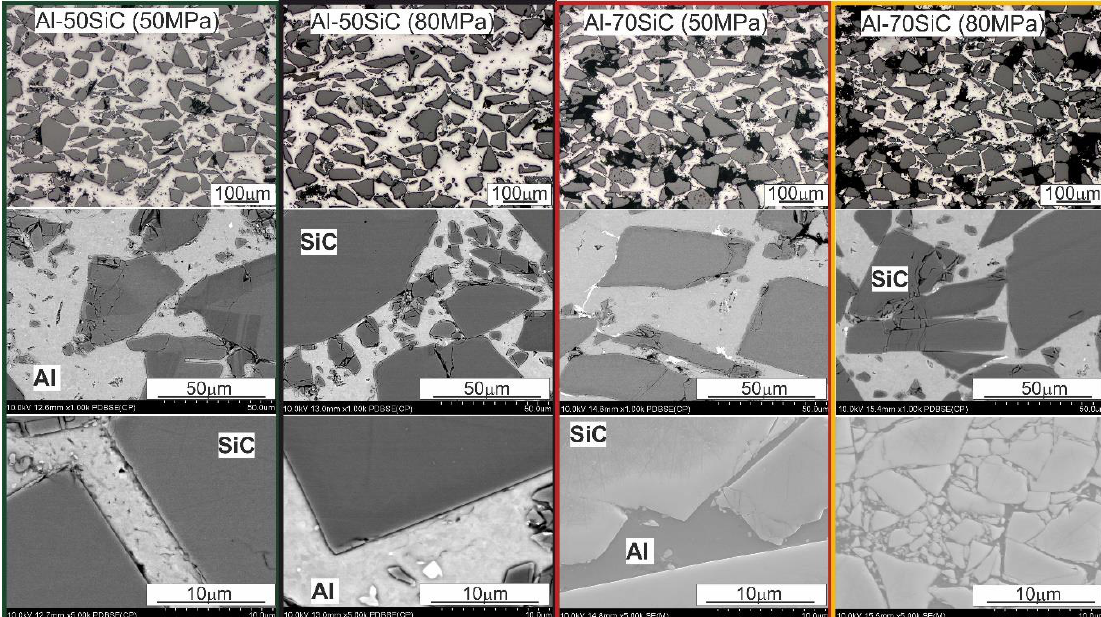
Figure 4. Microstructure of spark-plasma-sintered Al-SiC composites.